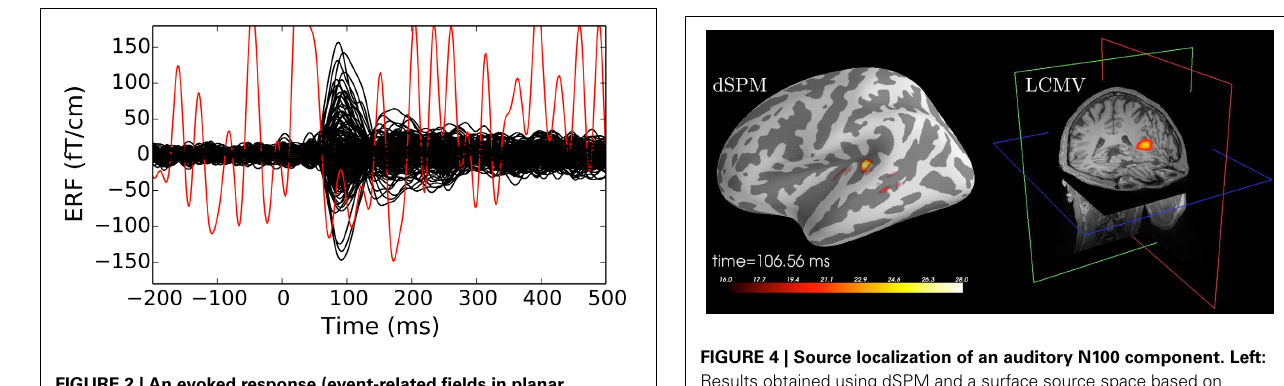
FIGURE 2 | An evoked response (event-related fields in planar gradiometers of an Elekta-Neuromag Vectorview system) showing traces for individual channels (bad channels are colored in red). Epochs with large peak-to-peak signals as well as channels marked as bad can be discarded from further analyses. The figure was generated using the plot method of the Evoked class.